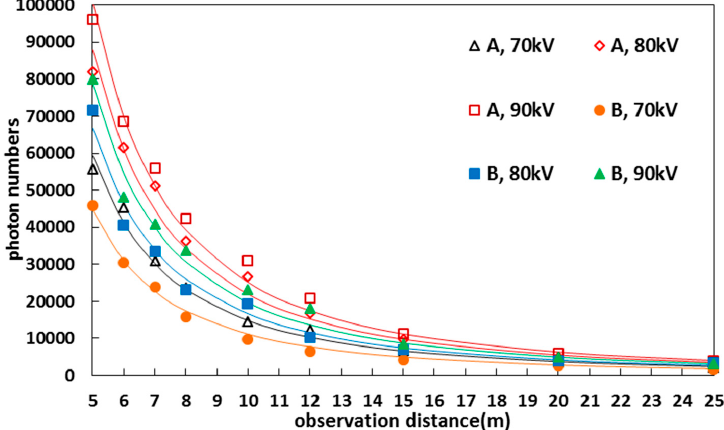
Figure 10. Influence of observation distance on photon numbers for sample I ( p = 98.09 kPa; T = 20 °C; RH = 78.2%).